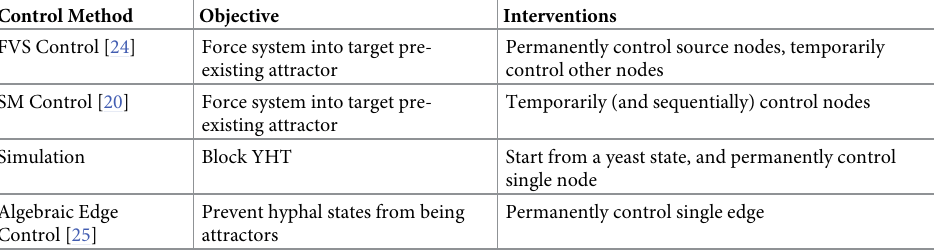
Table 3. An overview of the control prediction approaches we apply to the C . albicans YHT network, their objec- tives, and the types of interventions they